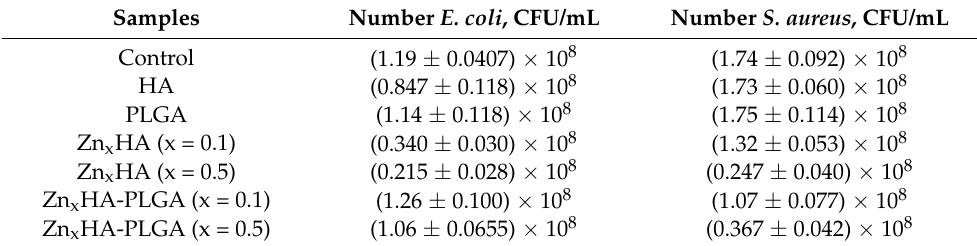
Table 3. Influence of different accessions on the abundance of E. Coli and S. aureus.